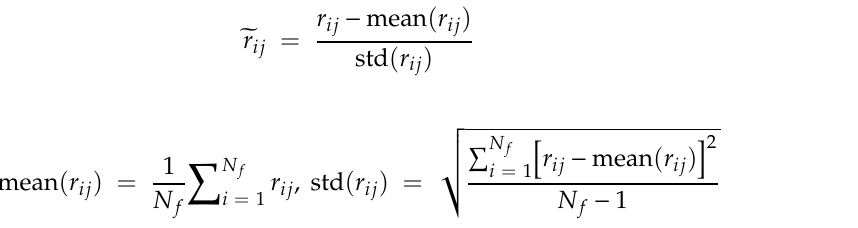
(13) The dashed line in Figure 4b marks the value of threshold. When the separability between the two pdfs was low, as the upper right of Figure 4b shows, the threshold was set higher for the sake of